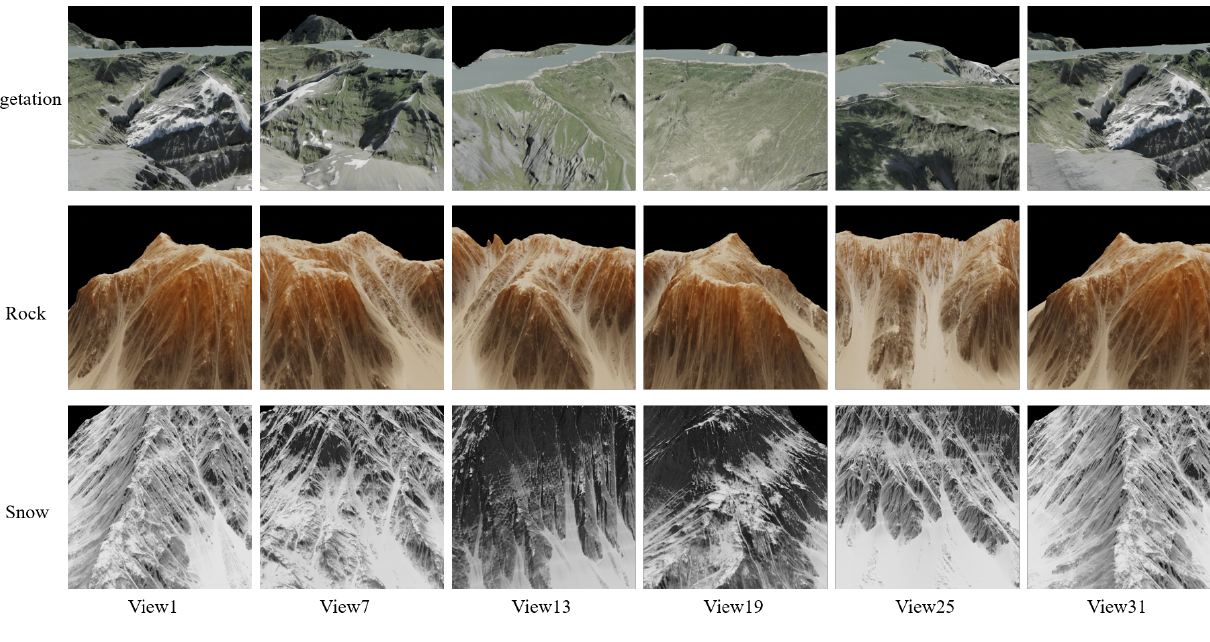
Figure 6. Input images of six camera views corresponding to each type of mountain terrain in the training set.